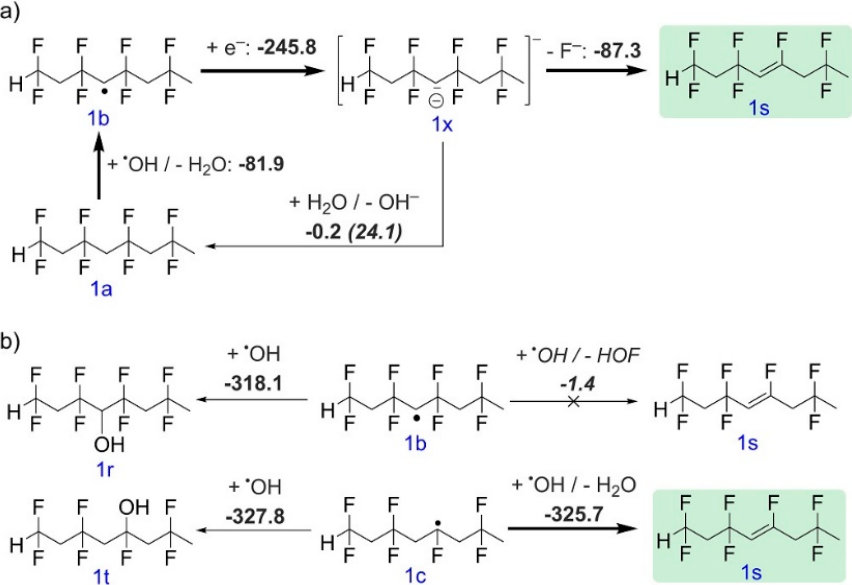
Figure 6. Amount of fluoride released after EB irradiation of PVDF, determined by ion chromatography ( n = 3). ( a ) Influence of water and irradiation dosage on extracted fluoride and ( b ) effects of scavenging individual water radiolysis products at an irradiation dosage of 50 kGy.